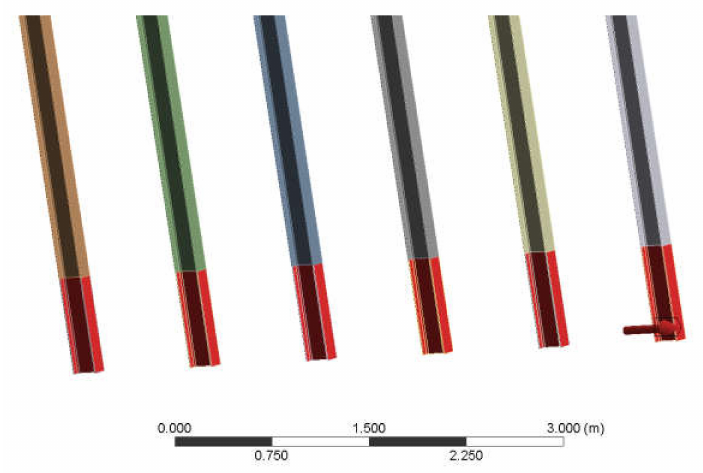
Figure 7. Scheme of the pressure applied to the middle steel piles of the bridge as a result of motionless water